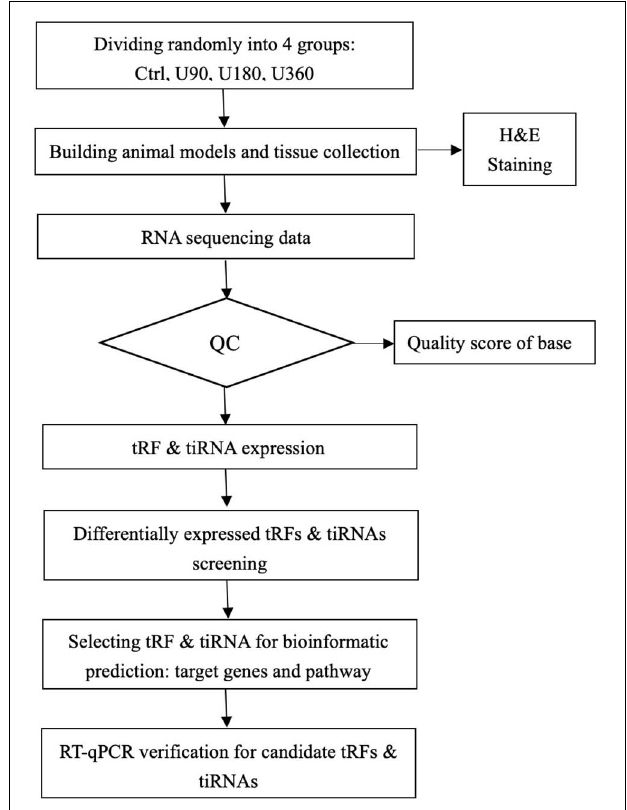
FIGURE 1 | tRF & tiRNA-seq experiment